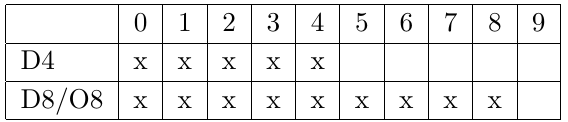
Table 1 . Brane intersection associated to the Brandhuber-Oz